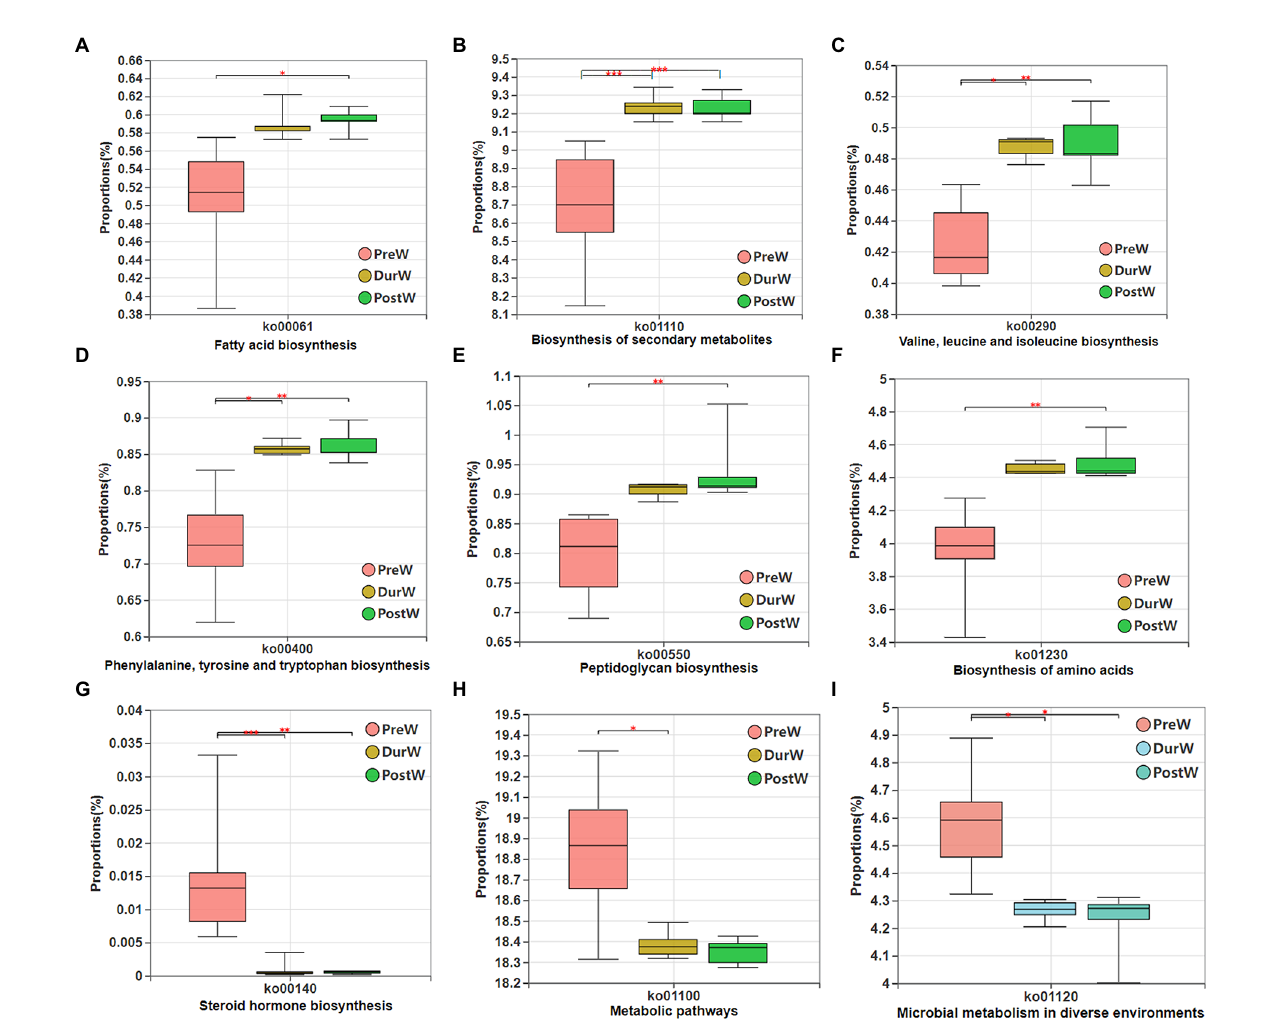
FIGURE 9 Variations in composition of bacterial KEGG metabolic pathways inferred by PICRUSt. KEGG, Kyoto Encyclopedia of Genes and Genomes; PICRUSt, the phylogenetic investigation of communities by reconstruction of unobserved states; PreW, pre-weaning donkeys; DurW, during weaning donkeys; PostW, post-weaning donkeys. * p < 0.05; ** p <0.01; *** p